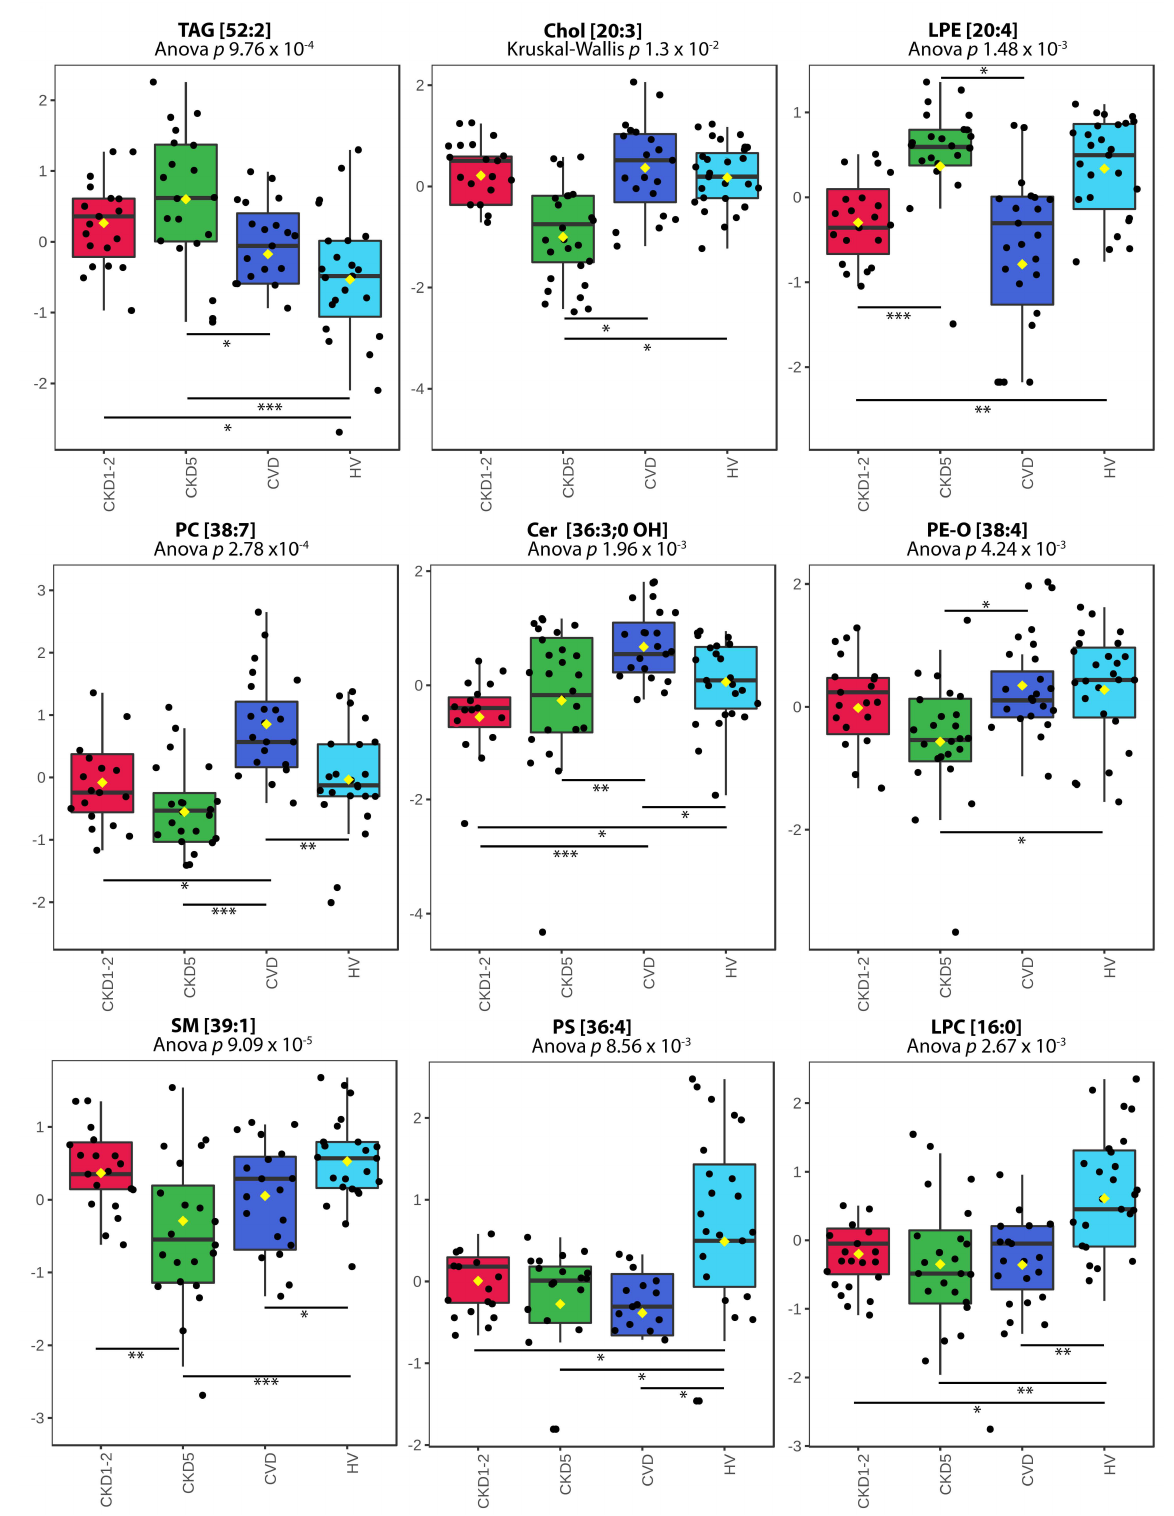
Figure 4. Abundances of representative species for all classes of lipids. ( A ) TAG [52:2]. ( B ) Chol [20:3]. ( C ) LPE [20:4]. ( D ) PC [38:7]. ( E ) CER [36:3:0, OH]. ( F ) PE-O [38:4]. ( G ) SM [39:1]. ( H ) PS [36:4]. ( I ) LPC [16:0]. A box on plot presents the interquartile ranges and medians. The black dots correspond to the normalized accumulation of selected lipid species in all samples. The notch indicates the 95% confidence interval around the median for each group. The mean level is indicated with a yellow diamond. Bars and asterisks show the results of U-Mann–Whitney/ t -test: * p < 0.05, ** p < 0.01, *** p < 0.001; n = 25 in each